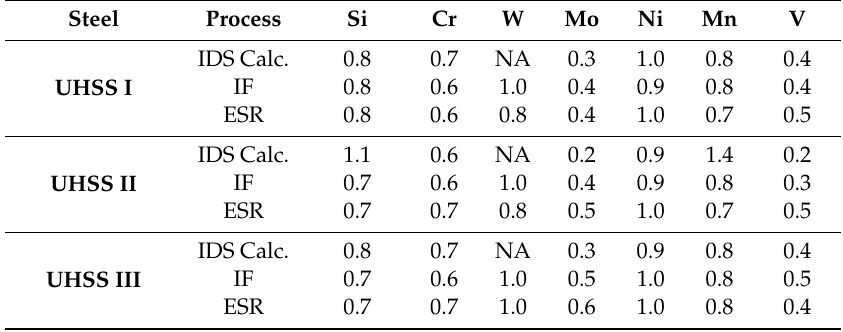
Table 6. Theoretical and experimental segregation indices ( ζ i ) for the alloying elements. Steel